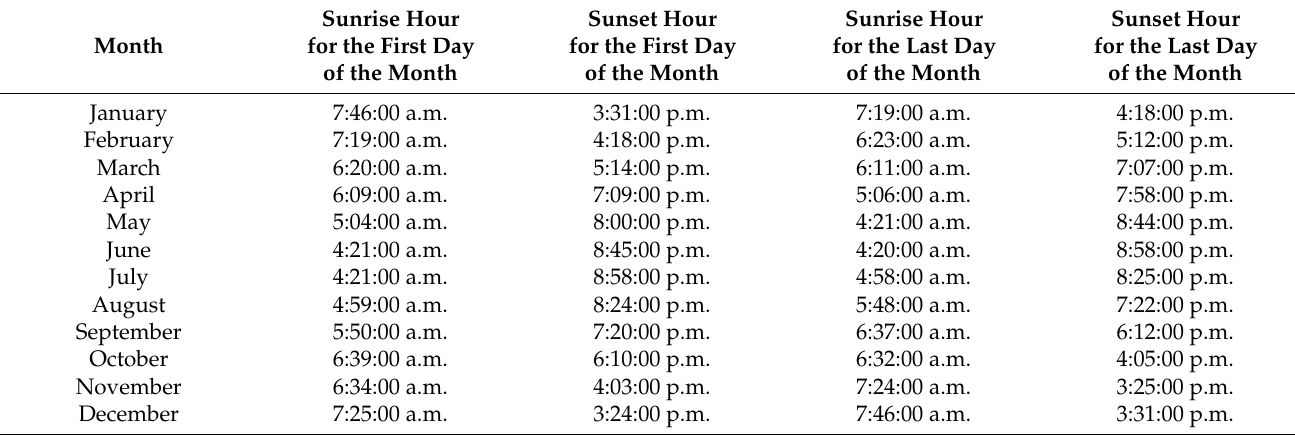
Table 3. Sunrise and sunset hours (at the beginning and end of the month—Slowackiego Street, Radzymin).